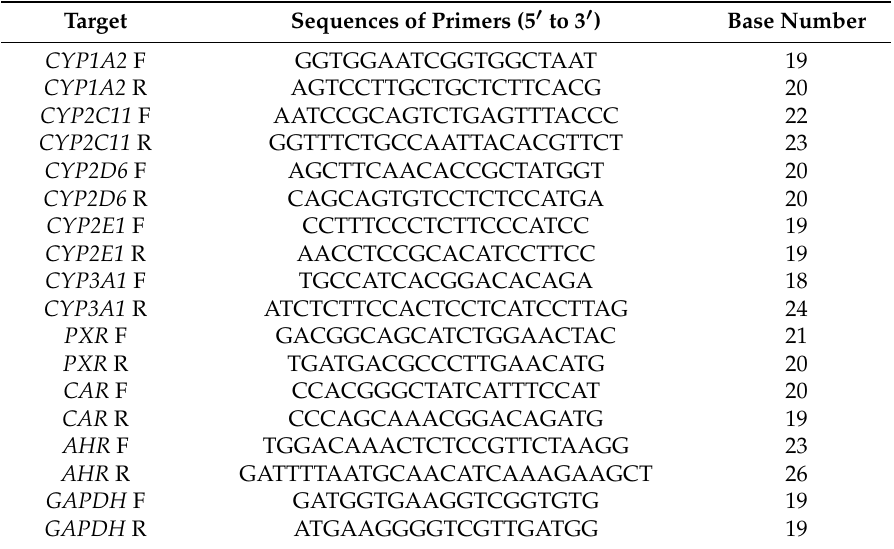
Table 1. PCR primers used for analysis of gene expression.